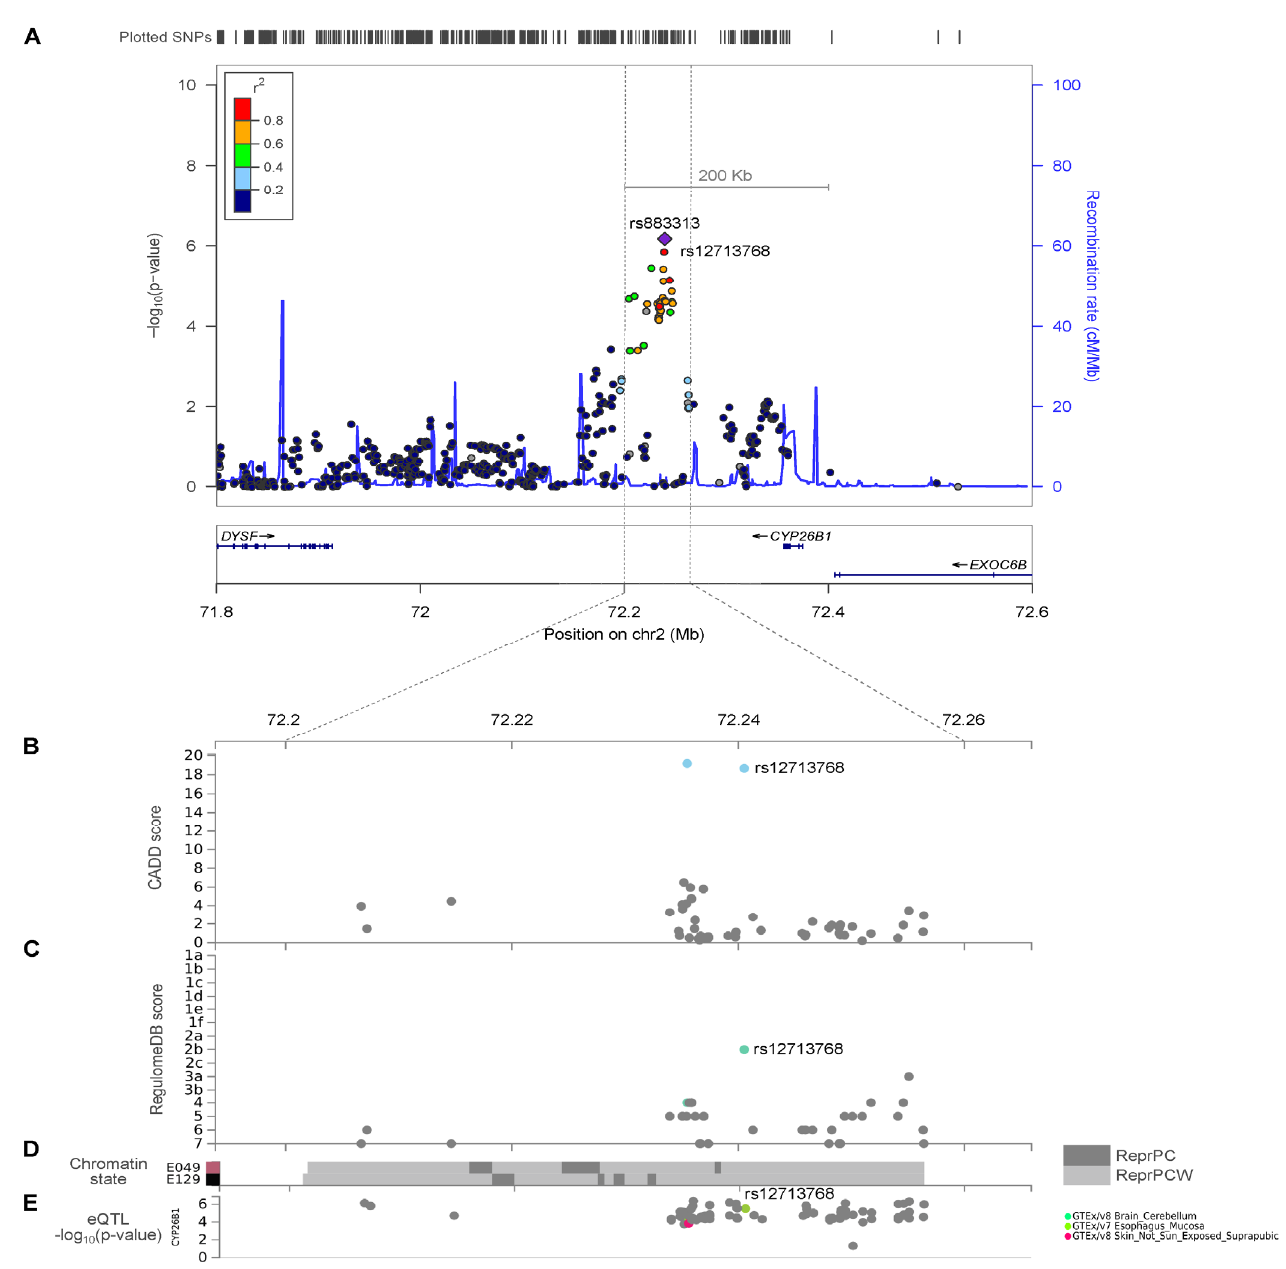
Figure 3. Regional plot for the novel loci associated with hand OA. ( A ) LocusZoom plot of the chromosome 2 locus at SNP rs883313 and rs12713768 showing –log 10 ( p -value) in the GWAS cohort, recombination rates in Han Chinese study populations, and annotated CYP26B1 protein coding transcript in the region below. Presented in the zoom in the region surrounding SNP rs12713768 are ( B ) CADD score, ( C ) RegulomeDB score, ( D ) chromatin state data of two tissue types: E049, human mesenchymal stem cell (hMSC)-derived cultured chondrocyte cells and E129, primary osteoblasts, and ( E ) eQTL data of CYP26B1 generated using FUMA. ReprPC, repressed by Polycomb. ReprPCW, repressed by Polycomb (Weak). eQTL, expression quantitative trait locus.